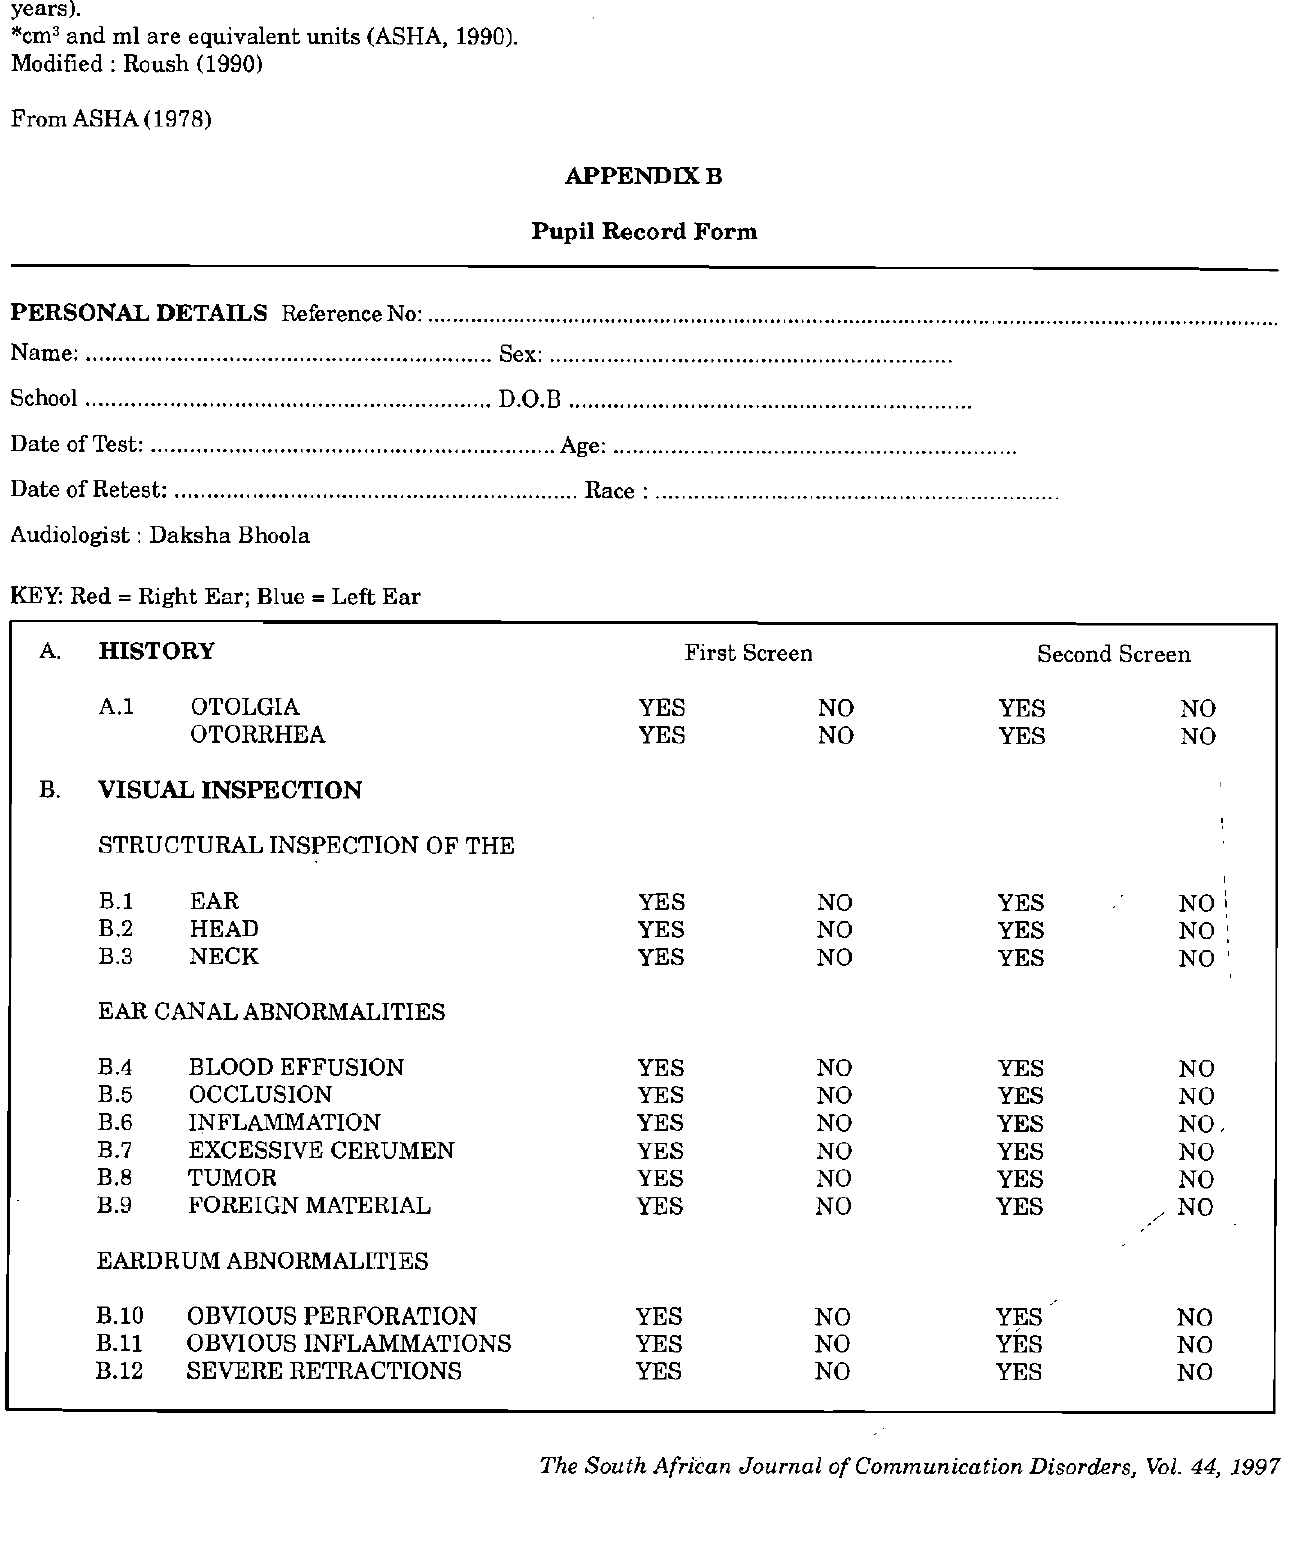
TABLE 2 : Interim Norms (Means and 90% Ranges) for Static Admittance (Peak Y), Equivalent Earcanal Volume (V cc ) and Tympanometric Peak Pressure (TPP) v PeakY TPP EC cm 3 /ml* daPa cm'/ml* Means 90% Range Means 90% Range Means 90% Range Children 0.05 0.2-0.9 0.7 0.4-1.0 100 -200 - +100 The values were extracted from Margolis & Heller (1987) who employed an acoustic immittance screening instrument (226-Hz) probe tone; pump speed -200 daPa/s that automatically compensated for earcanal volume by subtracting the admittance at 200 daPa from all values. Normative values for children were obtained from preschool-aged children (3-5